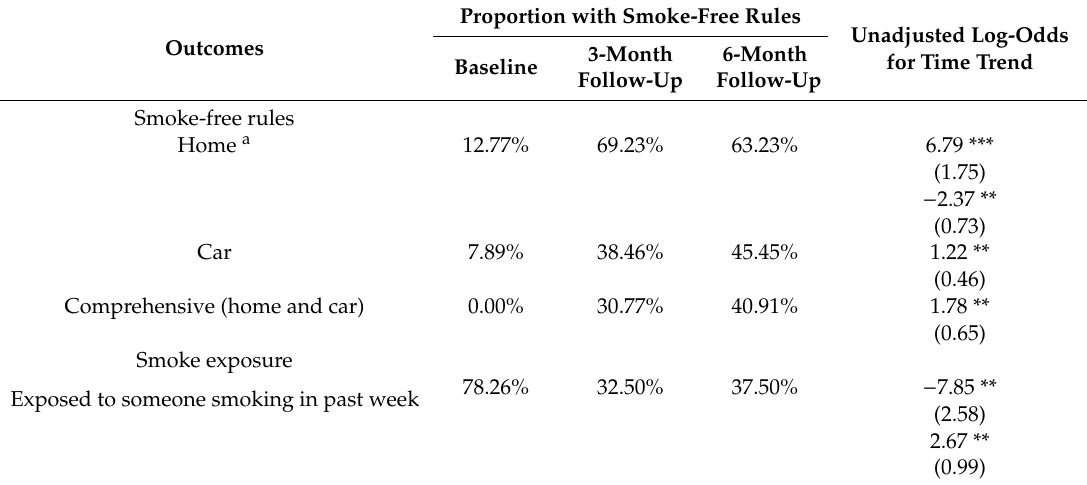
Proportion with Smoke-Free Rules Unadjusted Log-Odds 6-Month for Time TrendBaseline 3-Month Follow-Up Follow-Up